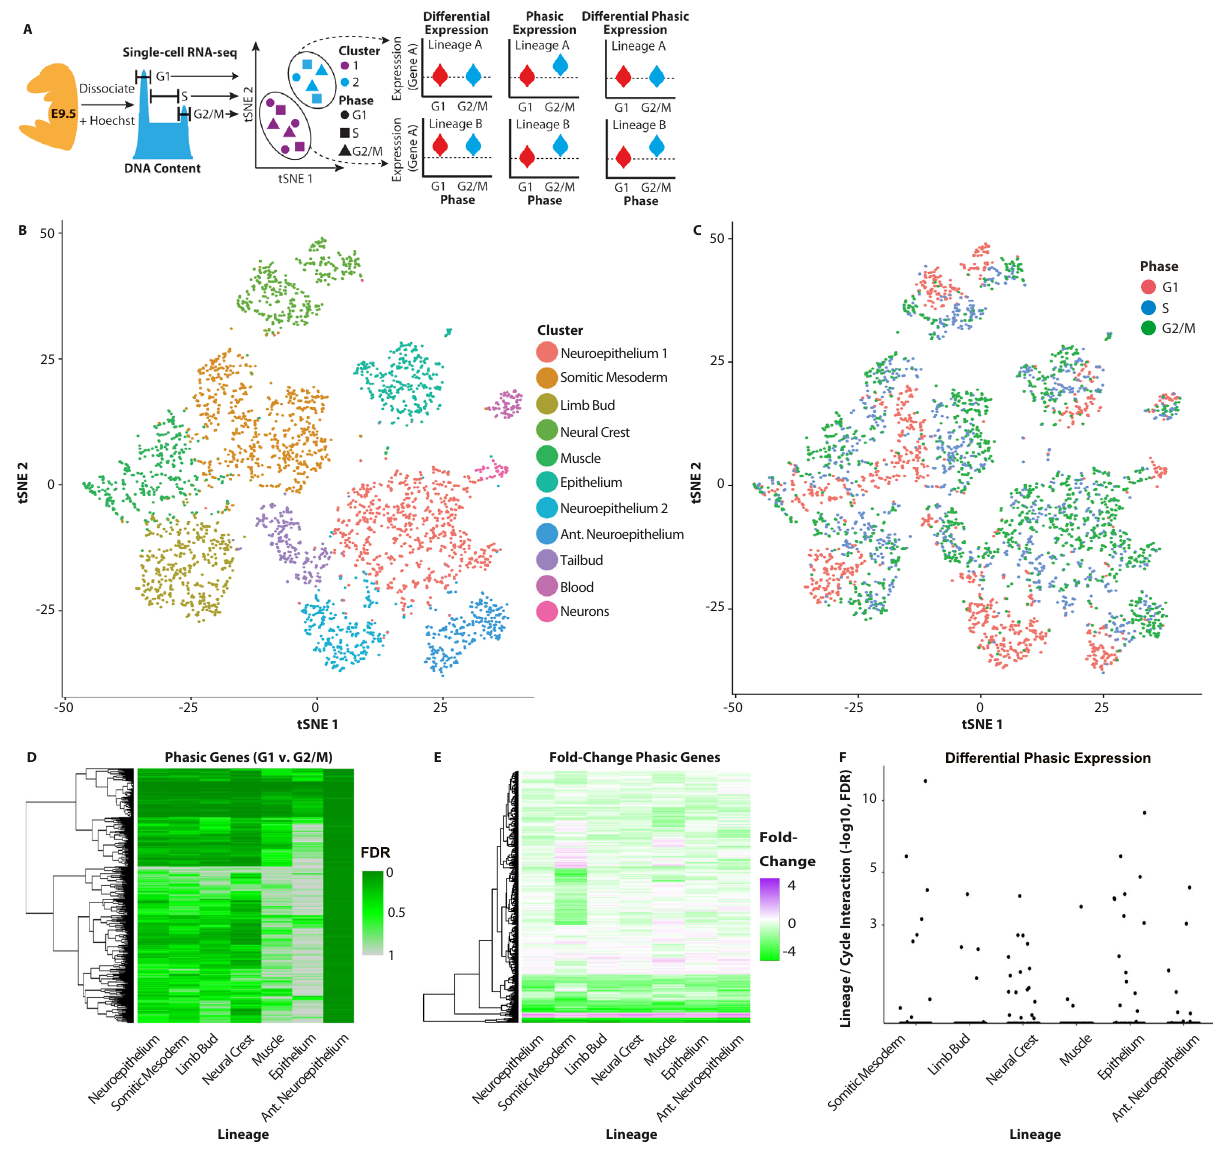
Fig. 3 Phasic programs differ between lineages in E9.5 embryos. A Schematized work fl ow for identifying lineage-speci fi c phasic programs. E9.5 embryos were dissociated to single cells, sorted by cell cycle phase based on DNA-content, captured by scRNA-seq, separated into lineages by t-Distributed Stochastic Neighbor Embedding (t-SNE), and then subjected to differential expression analysis accounting for lineage and phase. B t-SNE plot of 11 populations identi fi ed by shared nearest neighbor analysis of single-cell transcriptomes dissociated from whole E9.5 embryos. 13 PCA dimensions were reduced and depicted in the t-SNE plot. ( n = 2 biologically independent litters. Litters of 3 and 5 embryos were pooled as input for the respective samples.) C The distribution of cells by cell cycle phase as identi fi ed by DNA content within the clusters. D A heat map of P values for all genes within each lineage that showed differential expression between G1 vs. G2/M (BH adj. FDR < 0.05, Hurdle model (see Methods)). E The fold-change between G1 and G2/M of genes that are phasically expressed in at least one lineage (adj. P < 0.05 in “ D ” ). The source data is provided in “ Source Data.xlsx ” . F The distribution of − log10 FDR values of interaction term between phase and lineage. Dots represent genes that are distinctly phasic in each lineage relative to neuroepithelium (reference lineage) (BH adj. FDR < 0.05, Hurdle model (see